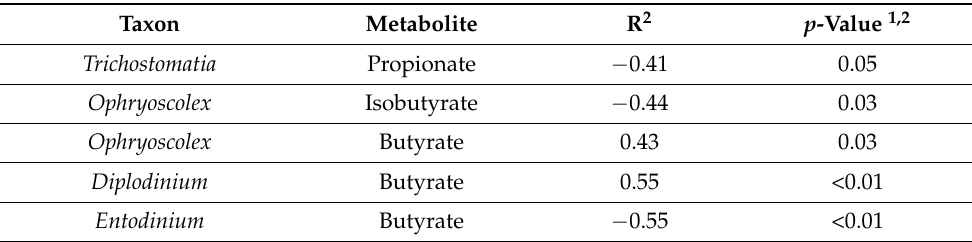
Table 5. Significant correlations between genera abundances of rumen protozoa and volatile fatty acid